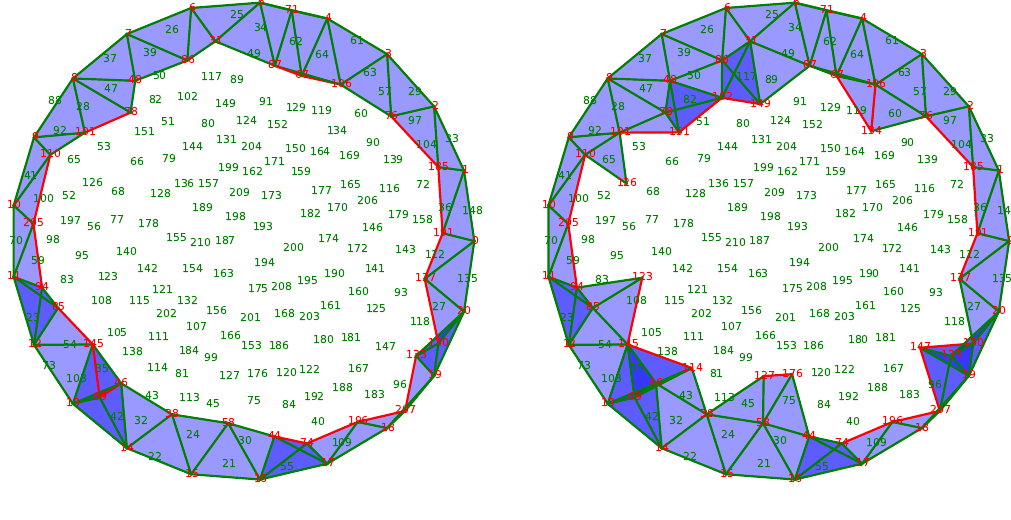
Figure 13. Steps of the second